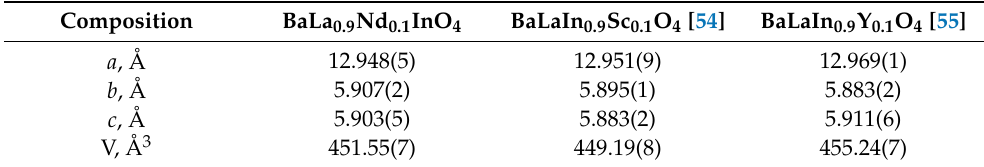
Table 2. The parameters of unit cell for the isovalent-doped compositions based on BaLaInO 4 .